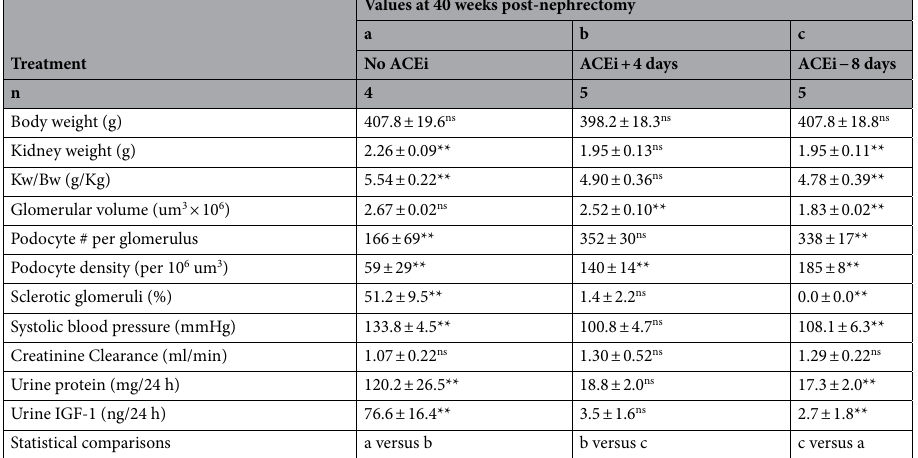
(Fig. 2). Systolic blood pressure measured by tail-cuff at 40-weeks was 136.3 ± 4.4 mmHg for sham-Nx rats and 140.3 ± 2.7 mmHg for Nx rats (NS). Over longer follow-up uni-Nx rats developed increasing glomerulosclerosis and death from uremia by about 15–18 months (data not shown).